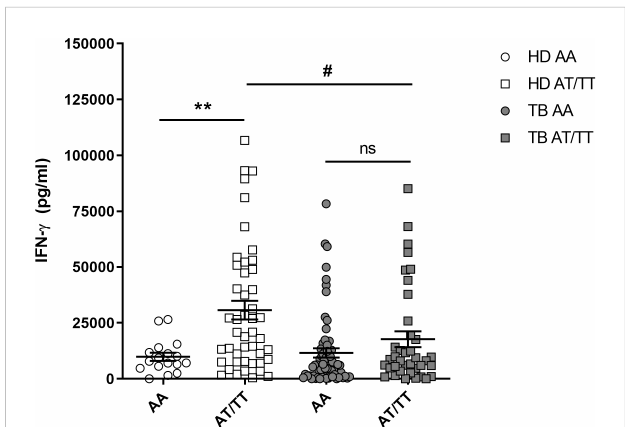
FIGURE 2 Production of IFN- g by PBMCs from HD and TB patients carrying the genotypic variants of the IFN- g gene (+874 A/T). PBMCs from healthy donors (HD, n = 63) and TB patients (TB, n = 102) carrying the different genotypes of the IFN- g gene (+874 A/T) SNP were stimulated for fi ve days with M. tuberculosis -Ag, and IFN- g production was determined by ELISA. P values were calculated by one way ANOVA and Tukey ’ s multiple comparison test. ** p < 0.01 between HD genotypes. # p < 0.05 between HD and TB patients AT/TT genotypes. ns, not sign fi cant.